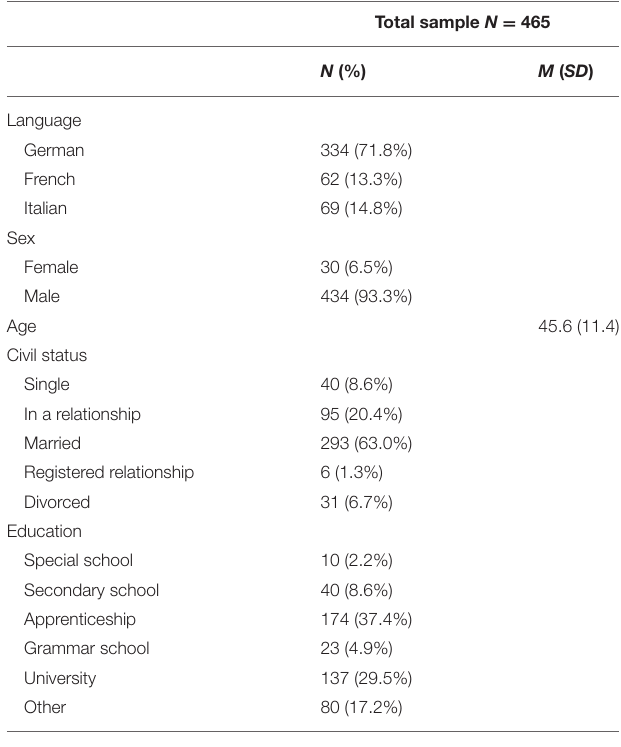
TABLE 1 | Sociodemographic characteristics of the Swiss mountain rescuers ( N =